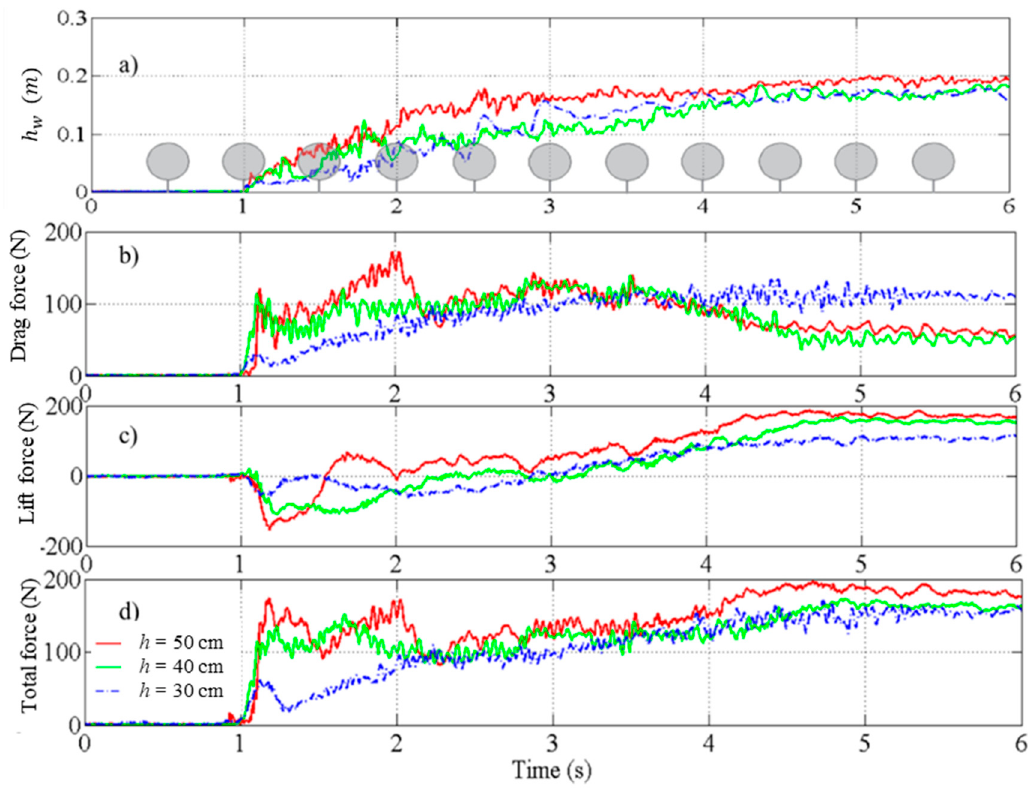
Figure 6. Time-history of the measured water level and force components for the dry bed condition for e / D = 0.3 and impoundment depths h = 50, 40, and 30 cm: ( a ) water level at WG3, ( b ) drag force time-history, ( c ) lift force time-history, and ( d ) total force time-history.